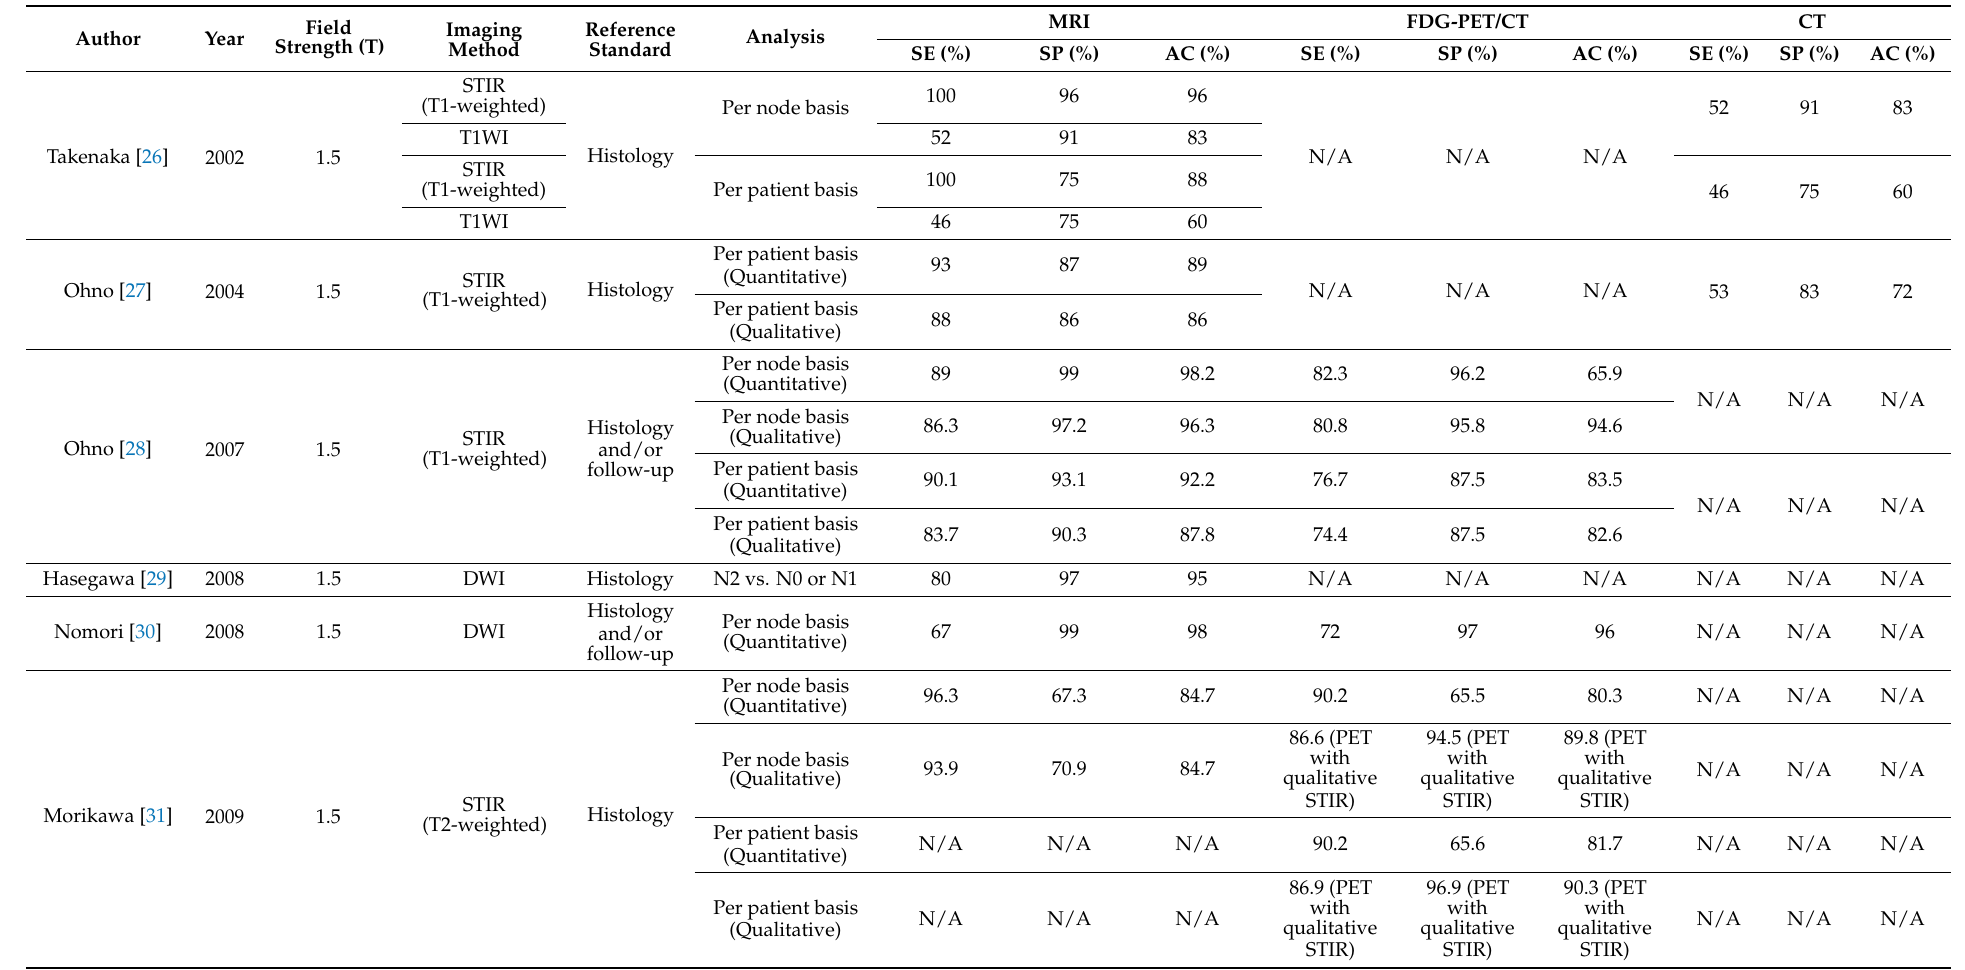
Table 3. Summary of diagnostic performance of N-factor assessment using dedicated chest